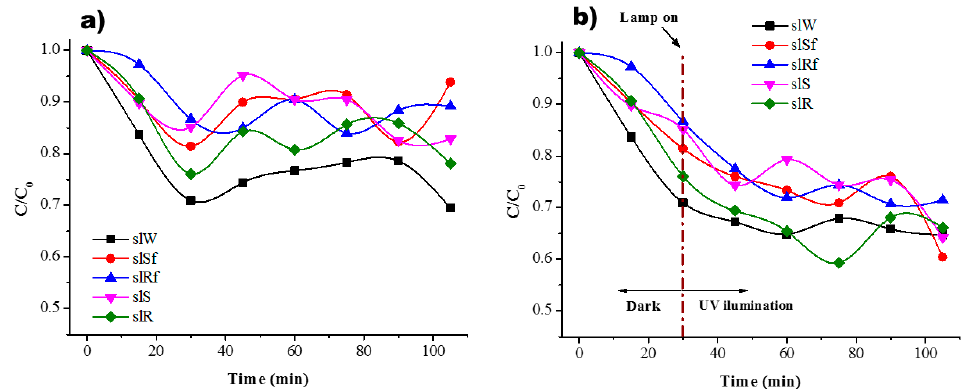
Figure 7. Residual concentration of MB ( a ) in dark conditions and ( b ) under UV irradiation for the SL paste and with ZnO nanostructures.